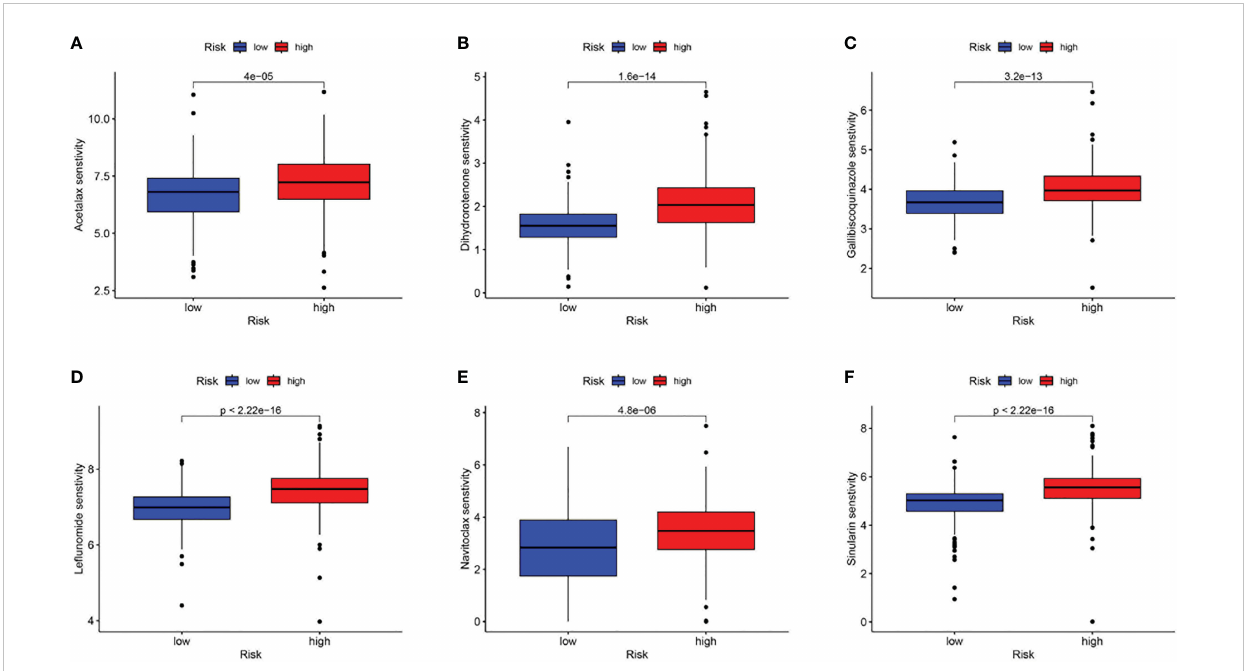
FIGURE 12 Association of CAF-riskScore with chemotherapy sensitivity. Estimated sensitivity for (A) acetalax, (B) dihydrorotenone, (C) gallibiscoquinazole, (D) le fl unomide, (E) navitoclax and (F) sinularin in high and low CAF-risk